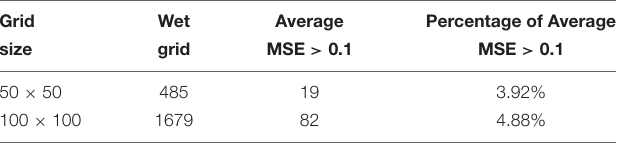
TABLE 2 | The impact of grid size on the ANN training.